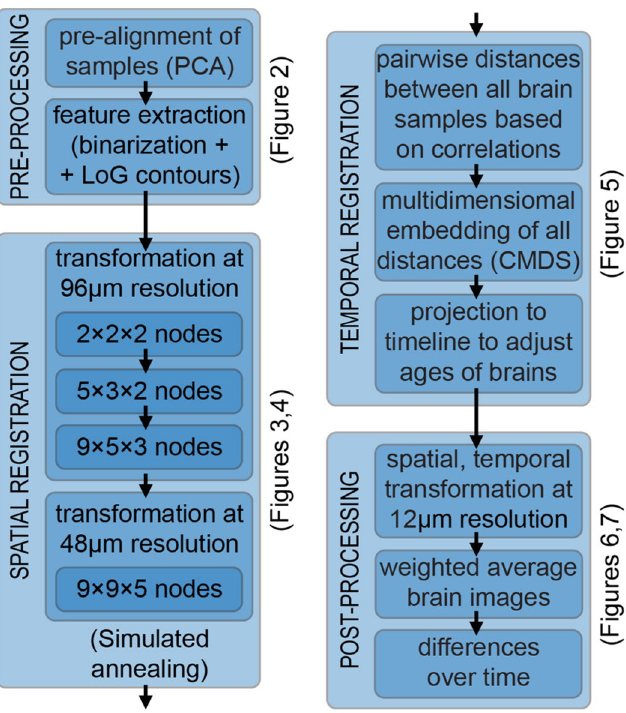
Figure 1. Flow chart of our algorithm for uncovering mesoscale developmental dynamics in the brain. To register brain samples, we start with preprocessing which includes pre-alignment using the principal component analysis (PCA) and extracting the image features to be registered. These features include brain region contours (extracted with Laplacian of Gaussian (LoG) filter) and the overall brain shapes (represented using the binary mask). We then perform spatial registration of brain samples using piece-wise linear deformations and an attention-gated simulated annealing Monte Carlo algorithm. We further register brain samples in